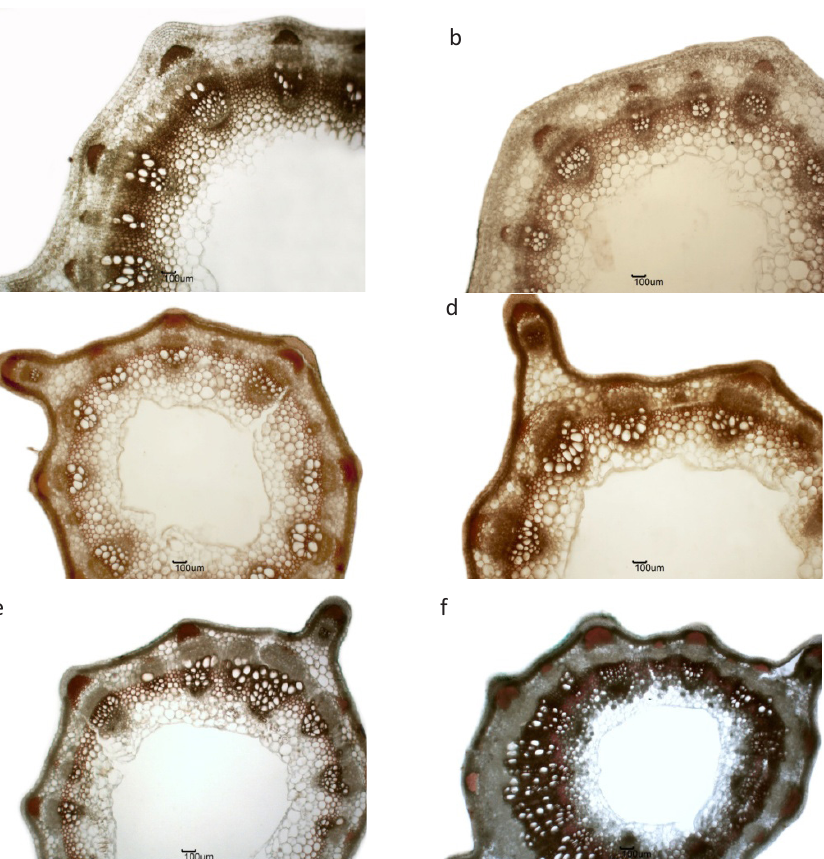
Fig. 6. Cross-sections of the middle stem segments. (a) V. narbonensis grown as sole stand; (b) V. narbonensis intercropped with L. albus ; (c) V. sativa spring-sown, grown as sole stand; V. sativa spring-sown intercropped with L. albus ; (e) V. sativa autumn-sown, grown as sole stand; (f) V. sativa autumn-sown intercropped with L.